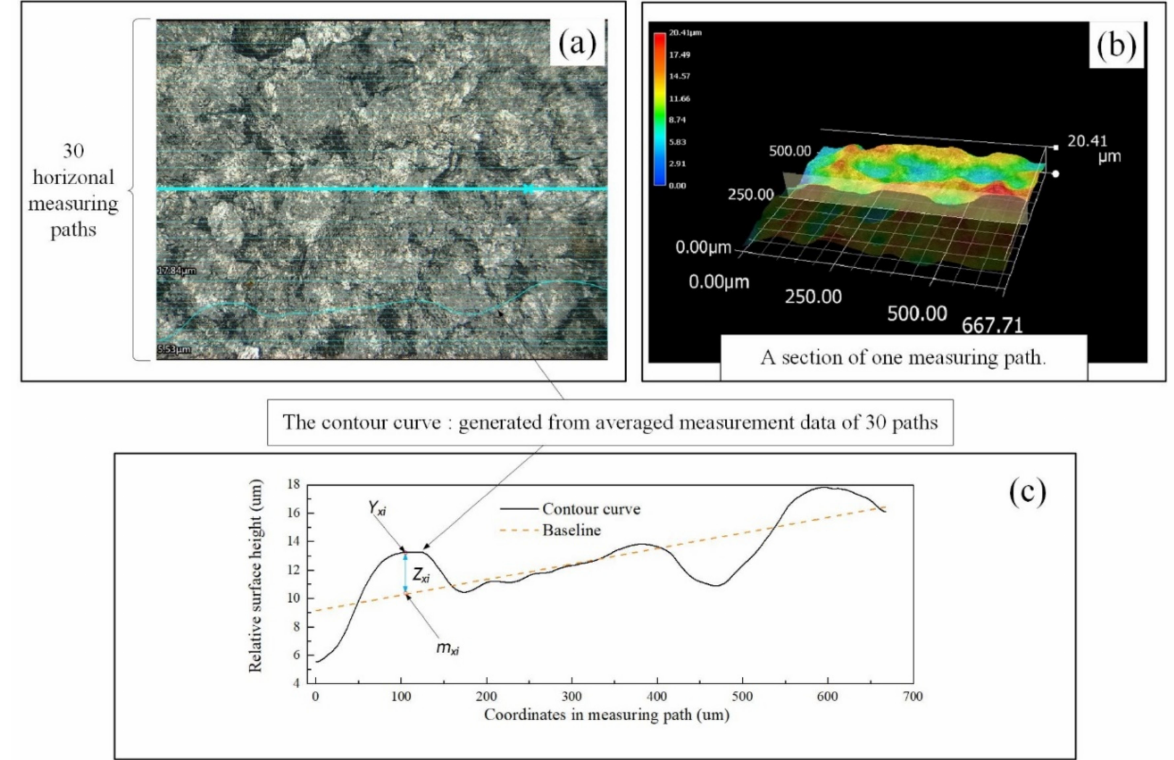
Figure 6. The schematic diagram of R a measurement and calculation: ( a ) the measuring paths along the specimen surface, ( b ) a section of surface measured by one path, ( c ) the contour curve and the baseline for R a